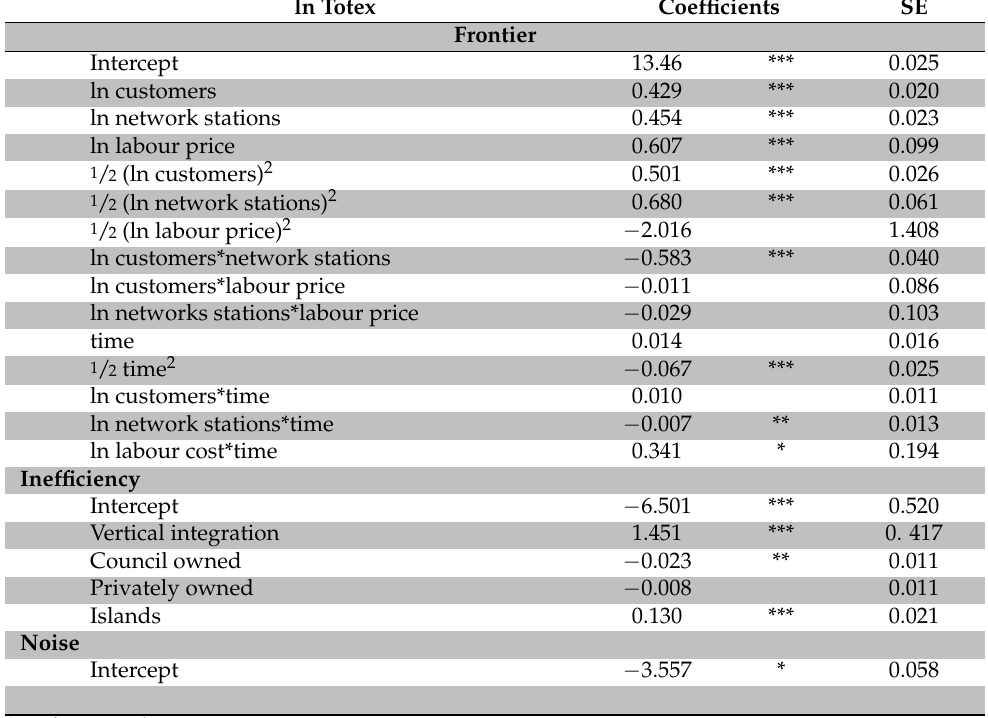
Table 3. Parameter estimates. Translog with inefficiency